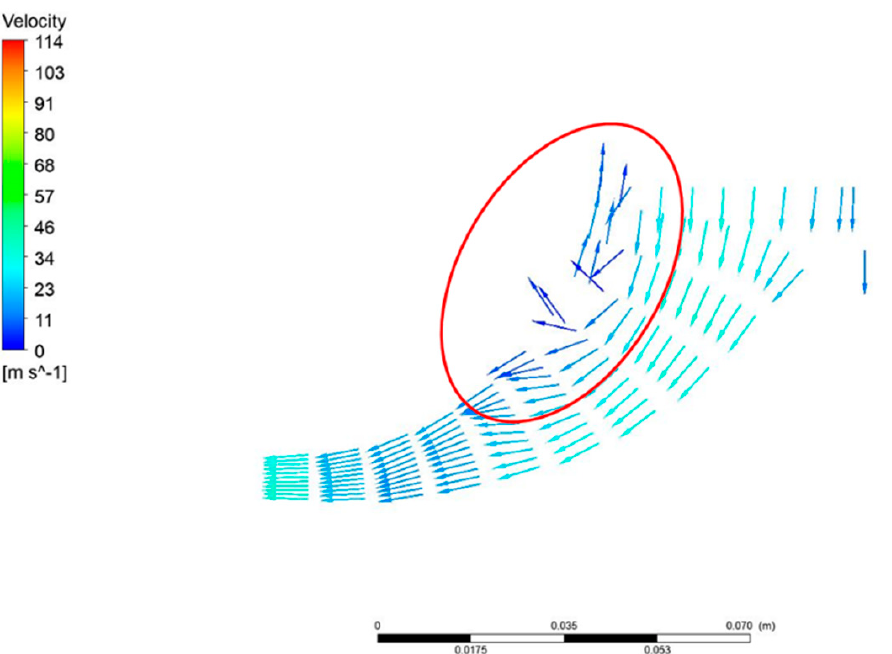
Figure 20. Compressor meridional velocity vector diagram of R-1234yf refrigerants under 25% load.